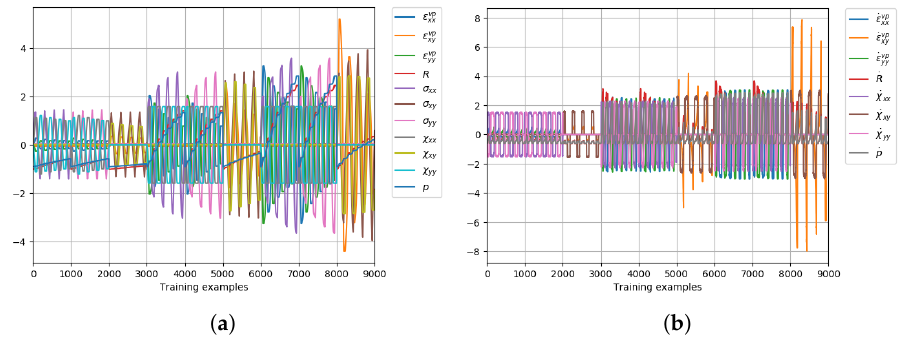
Figure 14. Normalized/scaled and adimensional values of the (generated) dataset used for training. ( a ) the scaled input data ( σ , χ , ε vp , R and p ) is transformed into the ( b ) scaled differential output data ( ˙ χ , ˙ ε vp , ˙ R and ˙ p ) by the virtual material